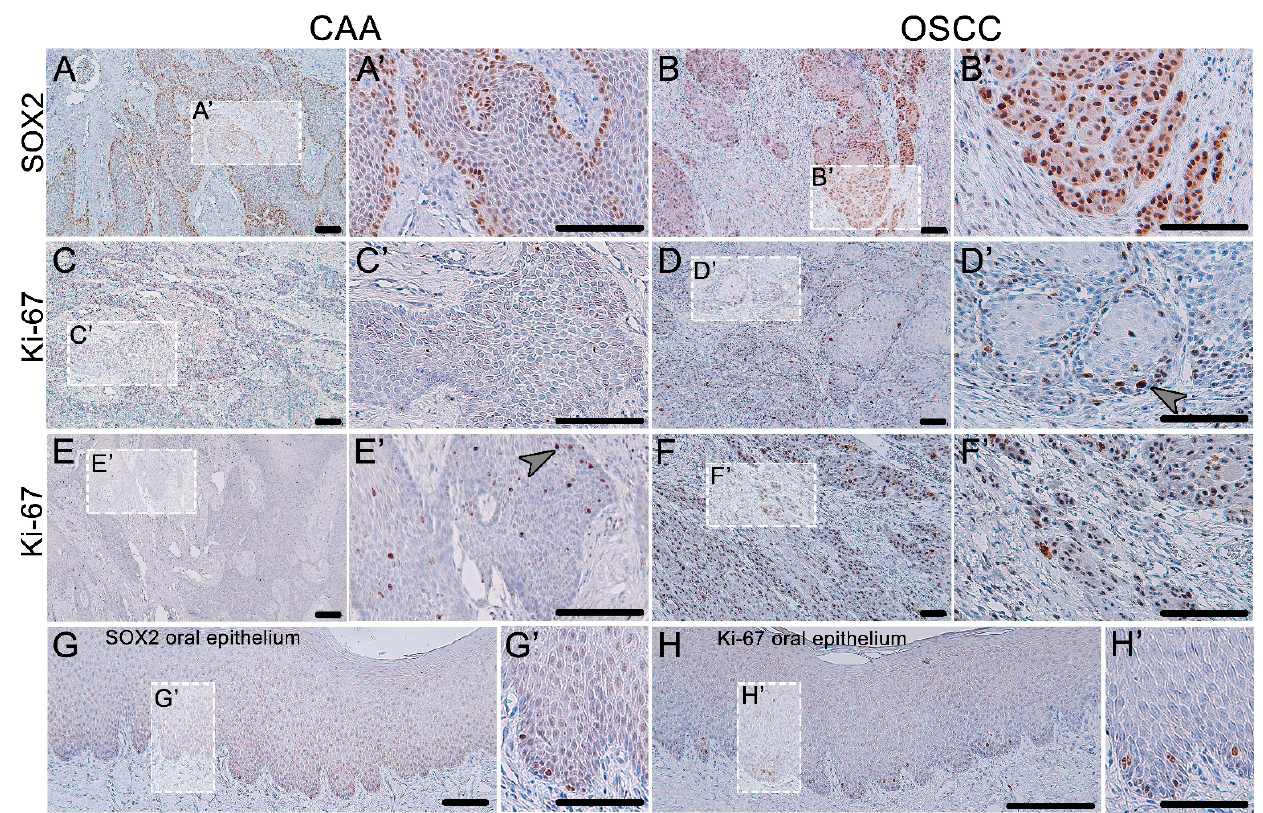
Figure 2. Expression of SOX2 and Ki-67 in CAA and COSCC. ( A ) In CAA, the expression of SOX2 is strong and is almost exclusively localized in the outer layer of neoplastic epithelial tissue. ( B ) In COSCC, the expression of SOX2 is strong and diffuse ( B ’) with an especially distinct signal in the areas of the tumor-invasive front and tumor budding. ( C , E ) The proliferation activity (Ki-67-positive cells) is rarely present in CAA ( E ’); only occasionally, there are areas of positive cellular nests (arrowhead). ( D ) In well-differentiated COSCC, the Ki-67-positive cells are present mainly in the outer layers of the epithelial islets (arrowhead). ( F ) Poorly differentiated COSCCs are diffusely Ki-67-positive with strong expression. ( G ) Normal canine oral epithelium has scattered SOX2-positive cells along the basement membrane and Ki-67 exhibit the same dispersed expression pattern ( H ). ( A’–H’ ) Higher magnification insert.